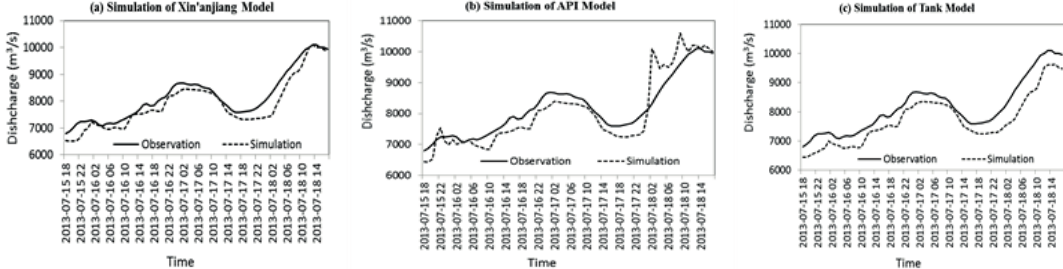
Fig. 3 Simulation flow hydrograph of flood event 2013-07-18. Simulations by: (a) Xin’anjiang, (b) API and (c) the Tank model.